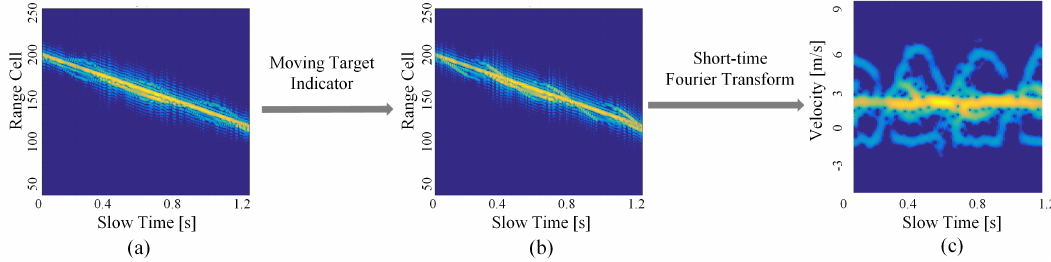
Figure 6. Radar data preprocessing: ( a ) Raw radar data; ( b ) radar data with background clutter suppression; and ( c ) radar MD signature.